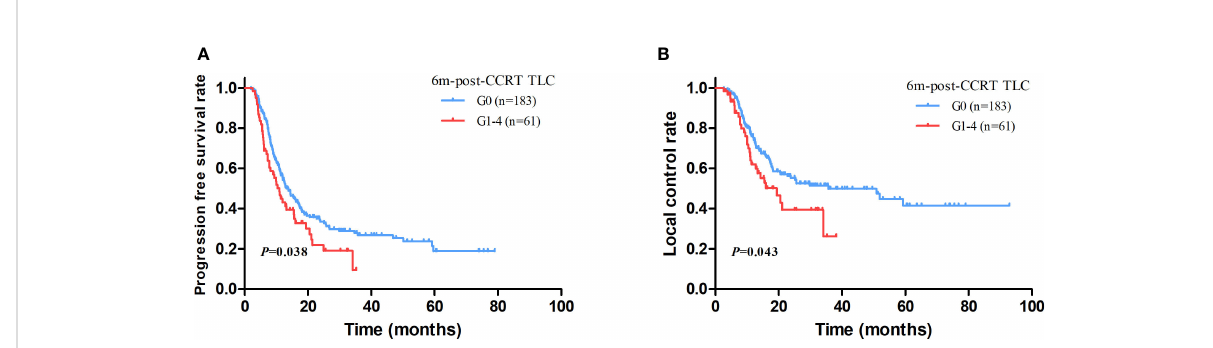
FIGURE 3 The association between progression free survival (PFS) (A) and local control (B) with 6m-post-CCRT TLC.